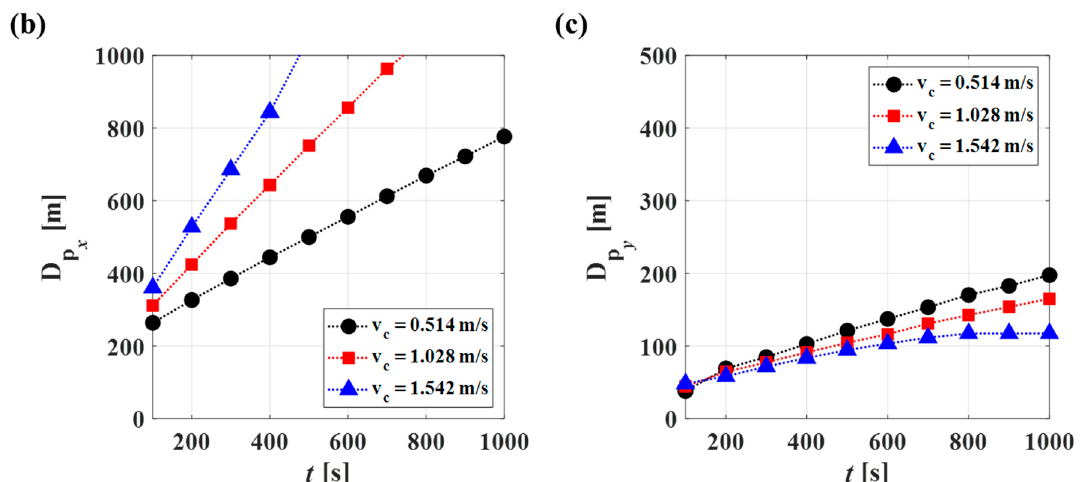
Figure 4. ( a ) Behavior of the interface at 50–200 s for the different current velocity with ρ hns = 800 kg/m 3 , and max propagation distance over time in the direction of ( b ) streamwise and ( c ) transverse with ρ hns = 800 kg/m 3 .